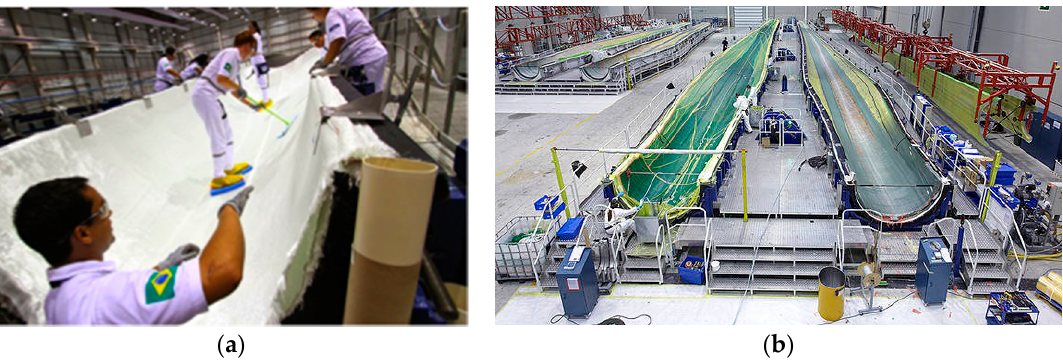
Figure 4. ( a ) Surface textile material application over the in-mould coating [6]; and ( b ) resin infusion process of a wind turbine blade